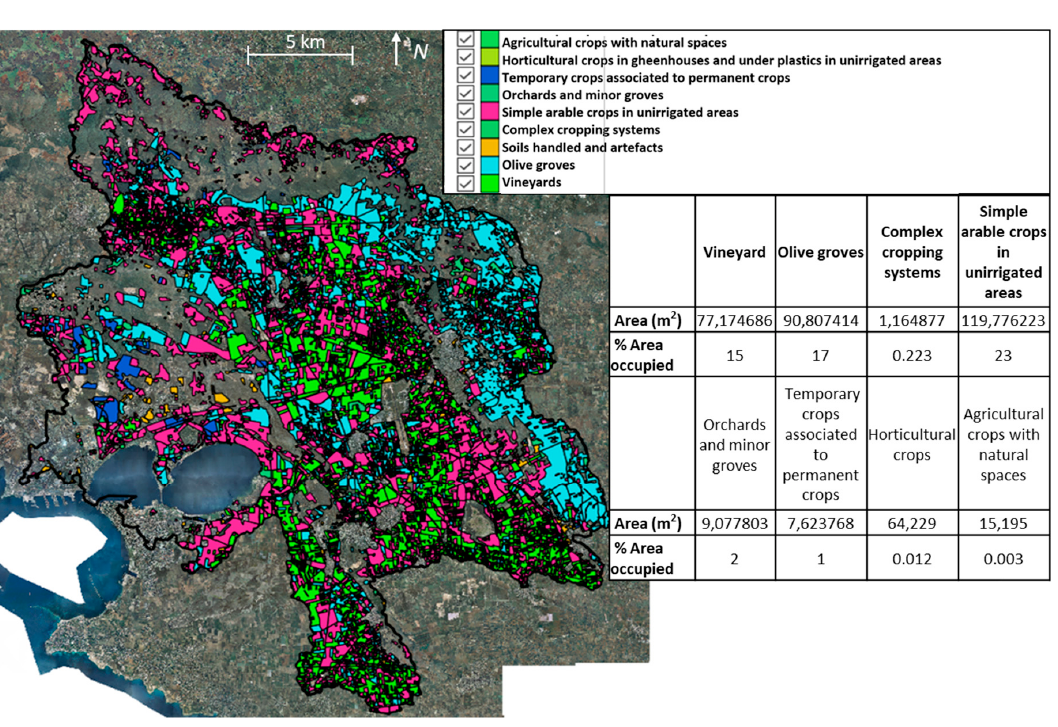
Figure 3. Types of agricultural areas falling into the Mar Piccolo catchment basin.